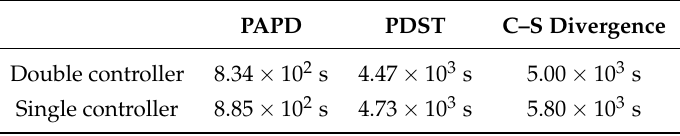
Figure 10. Performance evaluations (100 Monte Carlo trials). Table 1. The average computing time of the algorithms.